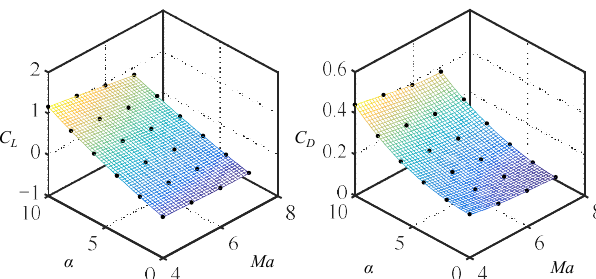
Figure 2. The change of C L and C D with angle of attack and Mach number.